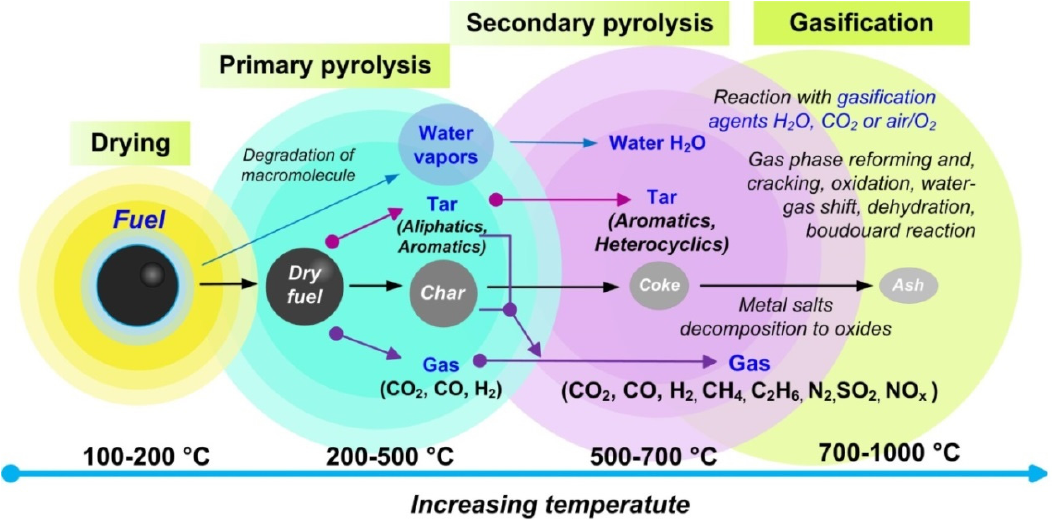
Figure 4. Scheme of thermal decomposition of a fuel particle indicating the main stages of pyrolysis and gasification.